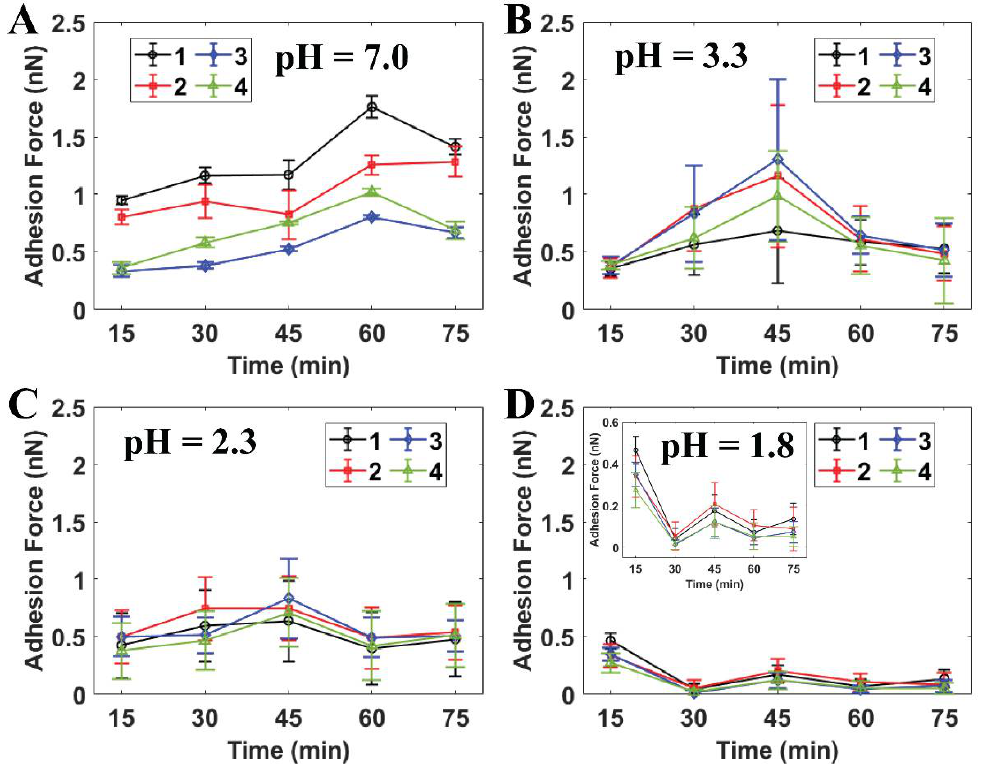
Figure 4. Quantitative adhesion forces of four individual S. mutans cells measured by AFM at ( A ) PBS pH 7.0, ( B ) citric acid pH 3.3 ( n = 20), ( C ) citric acid pH 2.3 ( n = 50), and ( D ) citric acid pH 1.8 ( n = 50). Note: Cells 1–4 are labeled as individual cells in Figure 3.